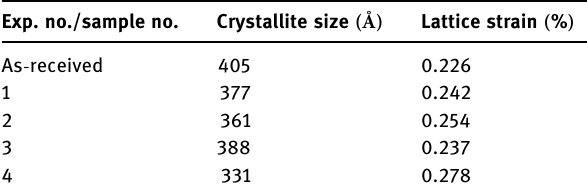
Table 7: Crystallite size and lattice strain of the XRD spectra at various machining parameters Exp. no./sample no.